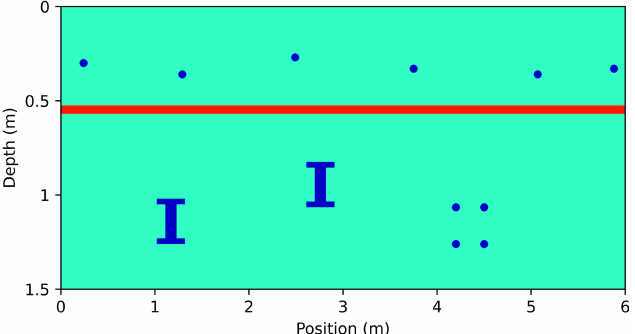
Figure 8. Tunnel lining